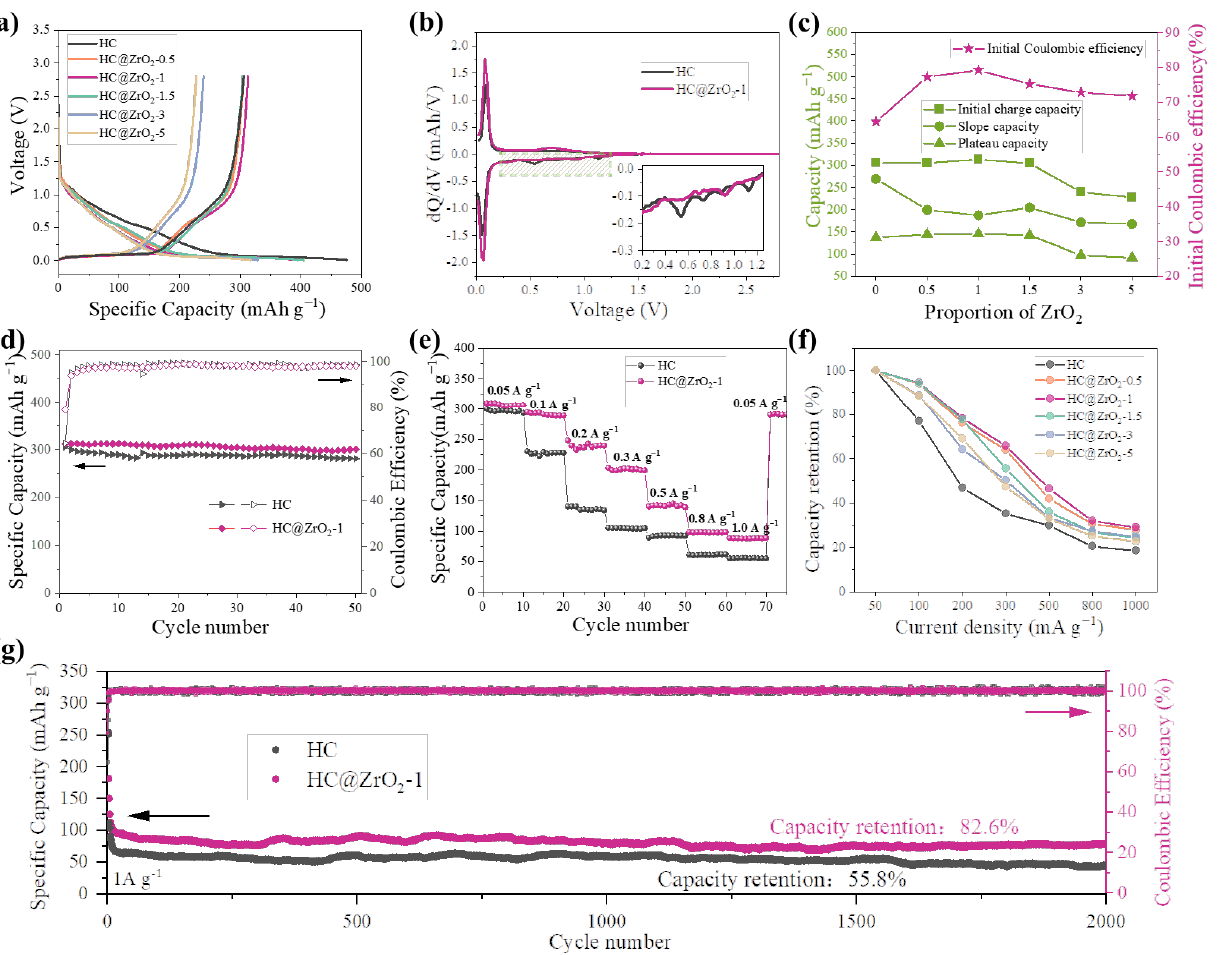
Figure 3. ( a ) Initial galvanostatic charge-discharge profiles of the HC and HC@ZrO 2 electrodes at 50 mA g −1 . ( b ) The dQ/dV versus voltage plots for the HC and HC@ZrO 2 -1 electrodes. ( c ) Summary of ICE, charge capacity, slope capacity, and plateau capacity of the HC and HC@ZrO 2 electrodes. ( d ) Cycling performance of the HC and HC@ZrO 2 -1 electrodes at 50 mA g −1 . ( e , f ) Rate performance and corresponding line chart of the HC and HC@ZrO 2 electrodes. ( g ) Long cycling performance of the HC and HC@ZrO 2 -1 electrodes at 1 A g −1 .